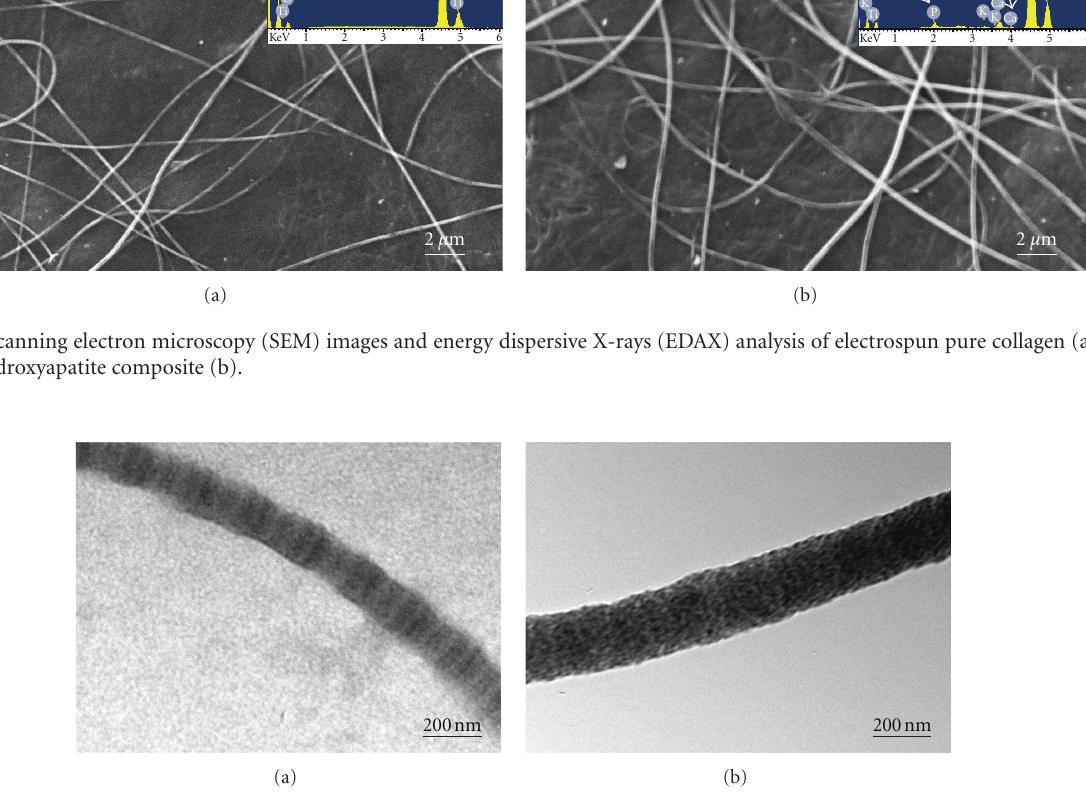
Figure 4: Transmission electron microscopy (TEM) images of electrospun pure collagen (a) and collagen-hydroxyapatite composite (b).